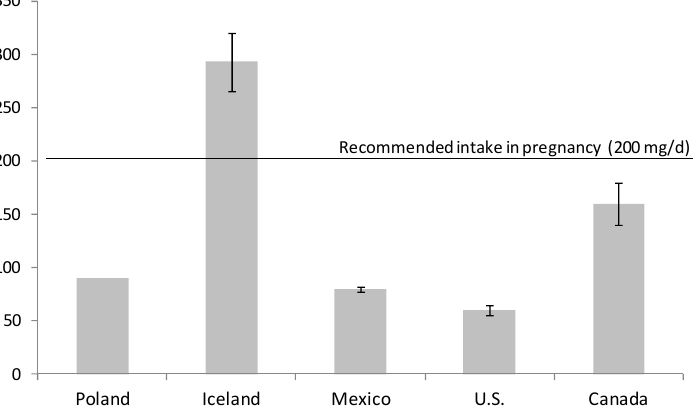
Figure 1. Estimated dietary docosahexaenoic acid (DHA) intake in pregnant women from different countries. Data from Innis and Elias 2003 [21], Parra-Cabrera et al. 2011 [18], Gunnarsdóttir et al. 2016 [23], Wierzejska et al. 2018 [24] and Zhang et al. 2018 [22].